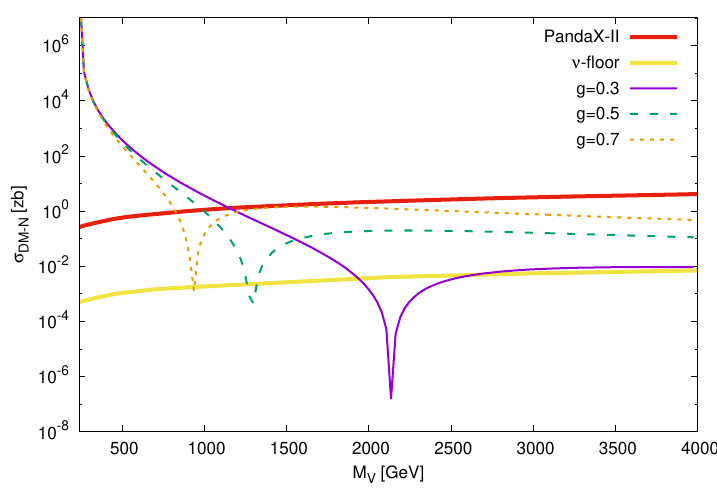
Figure 3 . DM-nucleon cross section as a function of vector DM mass for di(cid:11)ernet values of coupling g